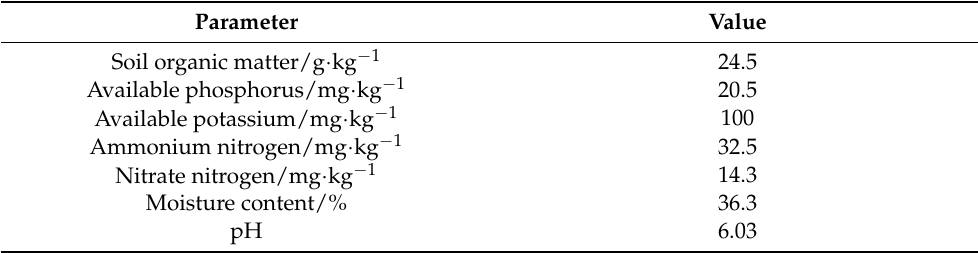
Figure 1. Mean temperature and rainfall during the experimental period. Table 1. Physical and chemical properties of test soil.